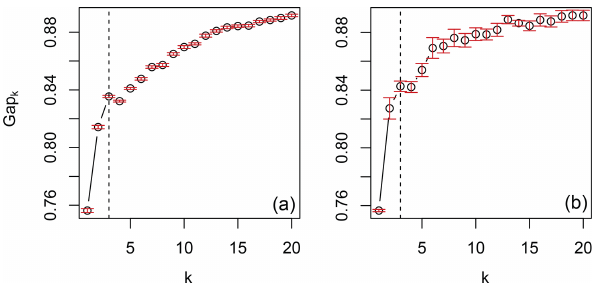
Figure 5. Gap statistic for length scales ≥ 8km produces a pro- nounced local maximum at k = 3, indicated by an “elbow” in both k -means (a) and k -medoids (b) clustering.